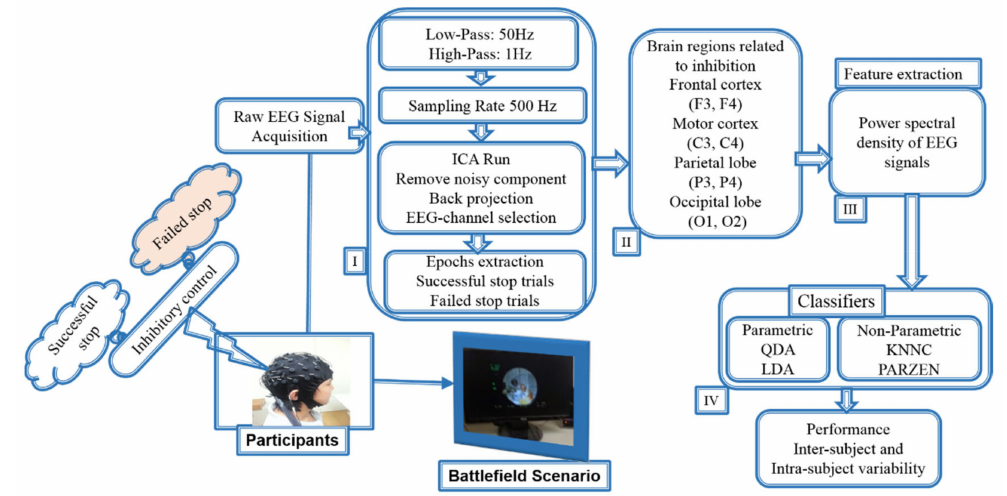
Figure 4. Flowchart of the classification system architecture. ( I ). Preprocessing steps of acquired EEG signals. ( II ). Human inhibition-related brain regions. ( III ). Analysis of EEG signals power spectral density (PSD) under inter-subject and intra-subject at preparation state before stimulus. ( IV ). The QDA and LDA (parametric) and KNNC and PARZEN (nonparametric) classifiers performance outcomes comparison during inter-subject and intra-subject